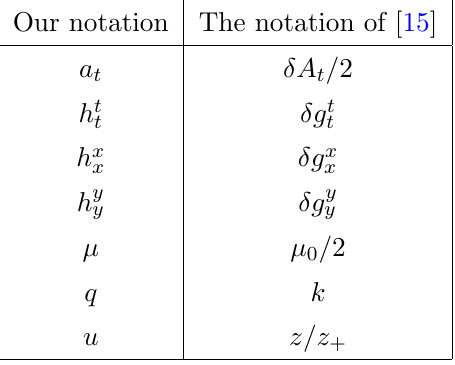
Table 1 . The Translation of